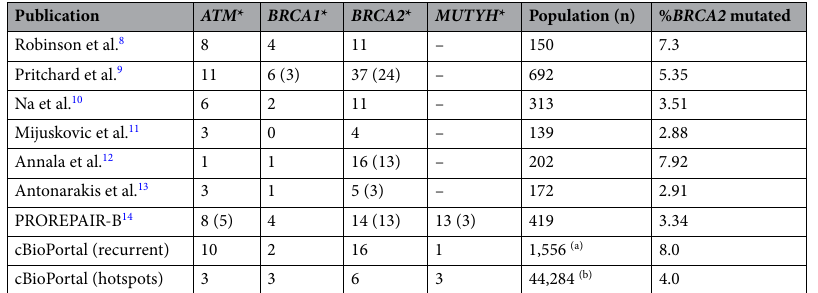
Table 2. Pathogenic germline variants identified in mCRPC cohorts and affecting the PCa relevant genes ATM , BRCA1 , BRCA2 and MUTYH . (*) Numbers indicate the total variants identified in each study and in parenthesis the non-identical germline variants. (a) From 11 PCa studies in the non-redundant dataset at cBioPortal. (b) From 176 different studies in the non-redundant dataset at cBioPortal. Details about the PCa populations in cBioPortal are provided in Supplementary File 1.